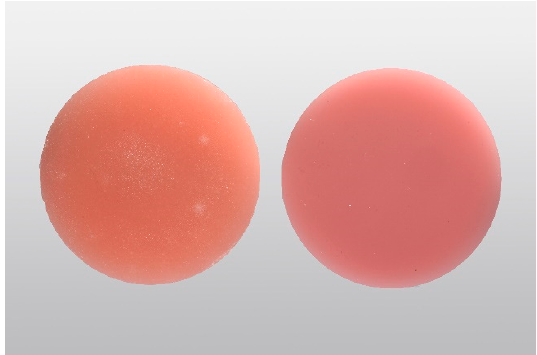
Figure 3. From left to right: Coe-Soft ( COE ) specimen after setting, Ufi Gel P ( UG ) specimen after setting.